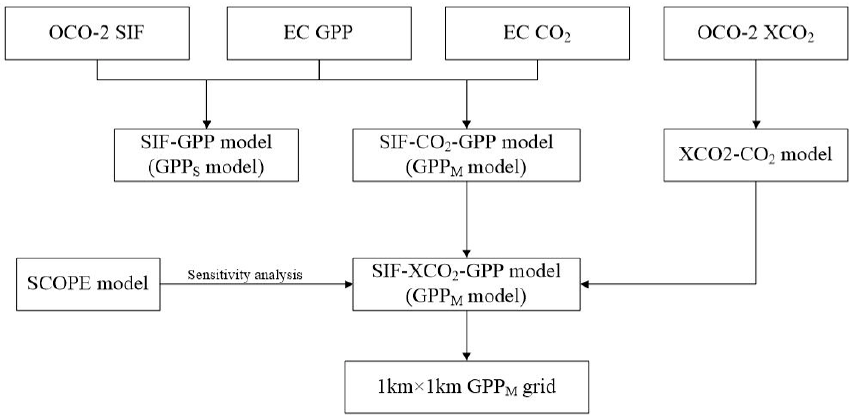
Figure 2. The flow diagram of this